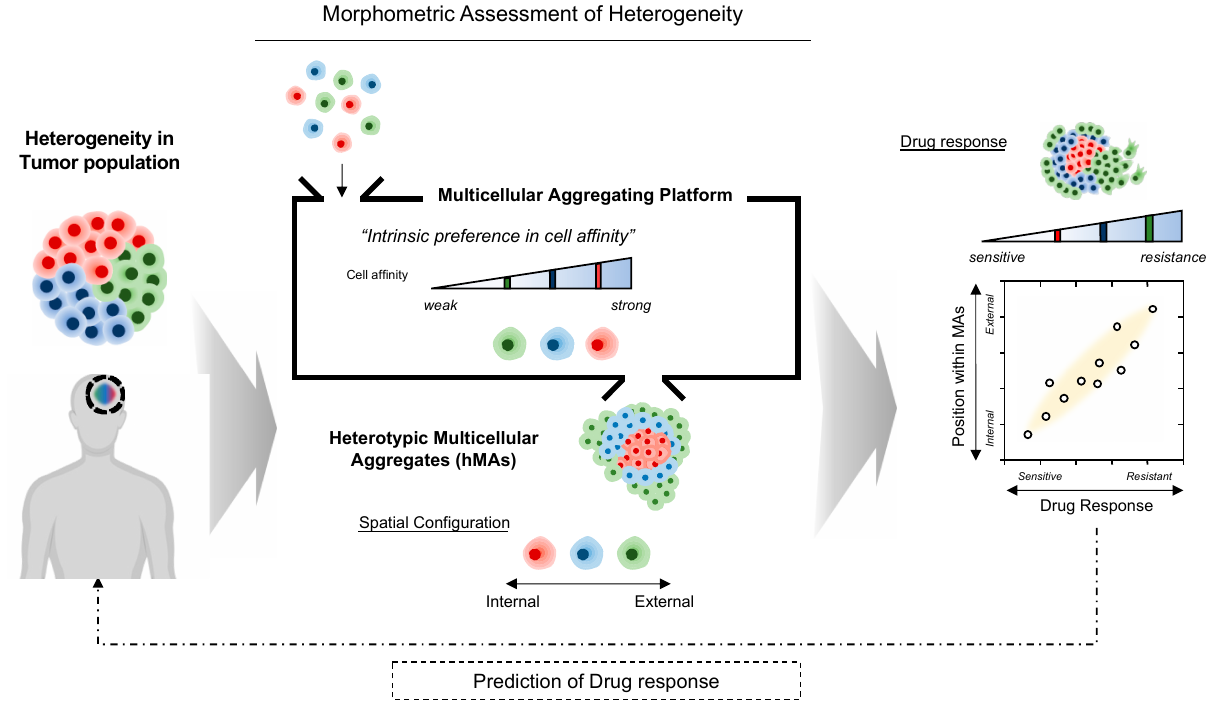
Figure 1. Illustrative overview of morphometric assessment of heterogeneous tumor cell populations based on intercellular affinity preferences. Multicellular aggregation of heterogeneous cell populations may result in a spontaneous 3D spatial configuration of cell aggregates, depending on the differential intercellular affinity.